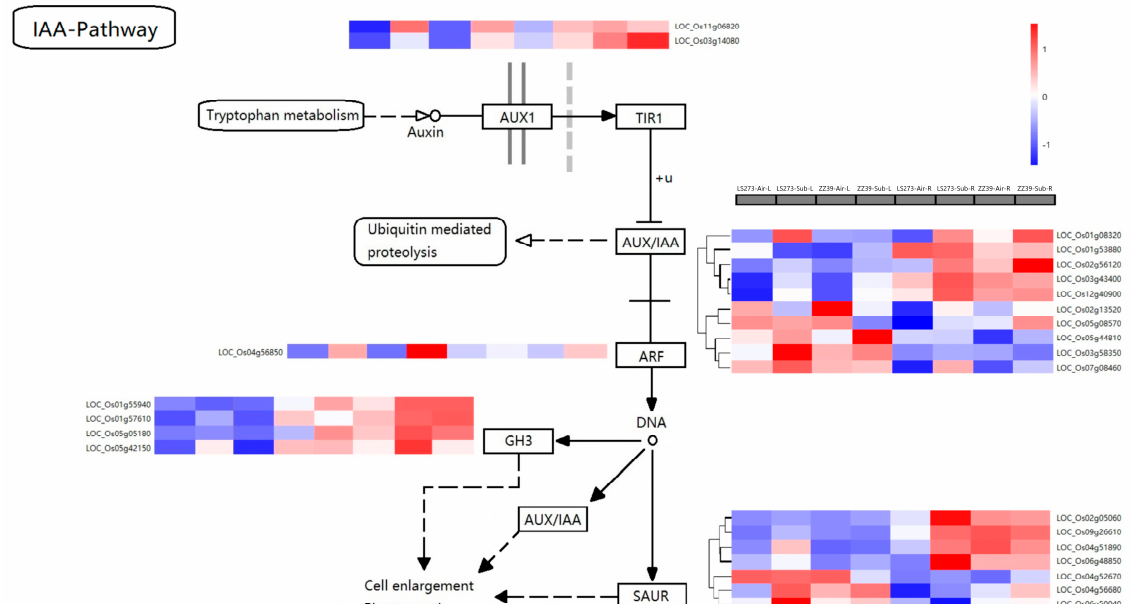
Figure 7. Expression of DEGs in the IAA pathway. LOC_Os05g44810 , LOC_Os03g58350 , and LOC_Os07g08460 belonged to the fourth group of genes, which were upregulated in LS273 shoots under submergence stress. ARF, as an auxin-responsive factor, can activate the expression of downstream genes, and LOC_Os04g56850 , as an auxin-response factor-related gene, was upregulated in both the shoots and roots under submergence stress compared with the blank control. The upregulation rate of the shoot was significantly higher than that of the roots. LOC_Os01g55940 , LOC_Os01g57610 , LOC_Os05g05180 , and LOC_Os05g42150 were associated with GH3-responsive genes. The expression of these DEGs in roots was much higher than in shoots. LOC_Os01g55940 was downregulated in LS273 shoots and upregulated in ZZ39 shoots. According to differences in gene expression, the SAUR gene family can be subdivided into four gene types. The expression of LOC_Os02g05060 and LOC_Os09g26610 in the shoots was lower than in the roots. The expression in LS273 was significantly upregulated under submergence stress but not significantly changed in ZZ39. Compared with the blank control, LOC_Os04g51890 and LOC_Os09g26610 expression in the shoots and roots were upregulated under submergence stress, and the upregulation in LS273 was significantly higher than in ZZ39. LOC_Os04g52670 expression in the shoot was higher than in the roots. When LOC_Os04g56680 and LOC_Os06g50040 were subjected to submergence stress, the variation of LS273 gene expression was greater than that of